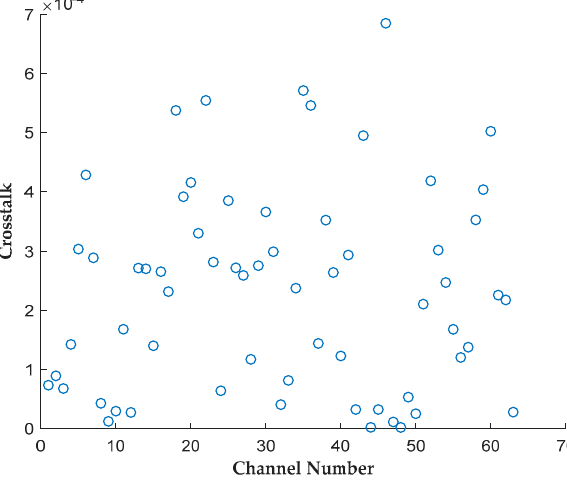
Figure 14. Crosstalk of every two adjacent channels.